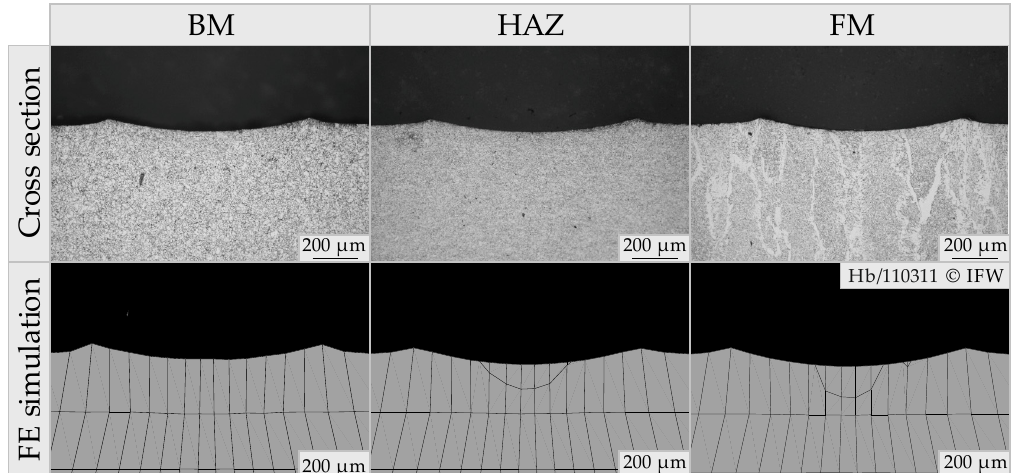
Figure 7. Comparison of experimentally and numerically determined single track geometries for d b = 3.175 mm, p r = 40 MPa and N = 10.